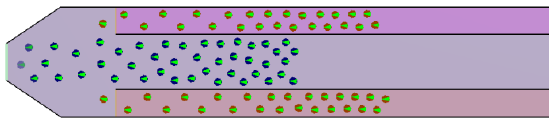
Figure 9. Trapezoidal export and